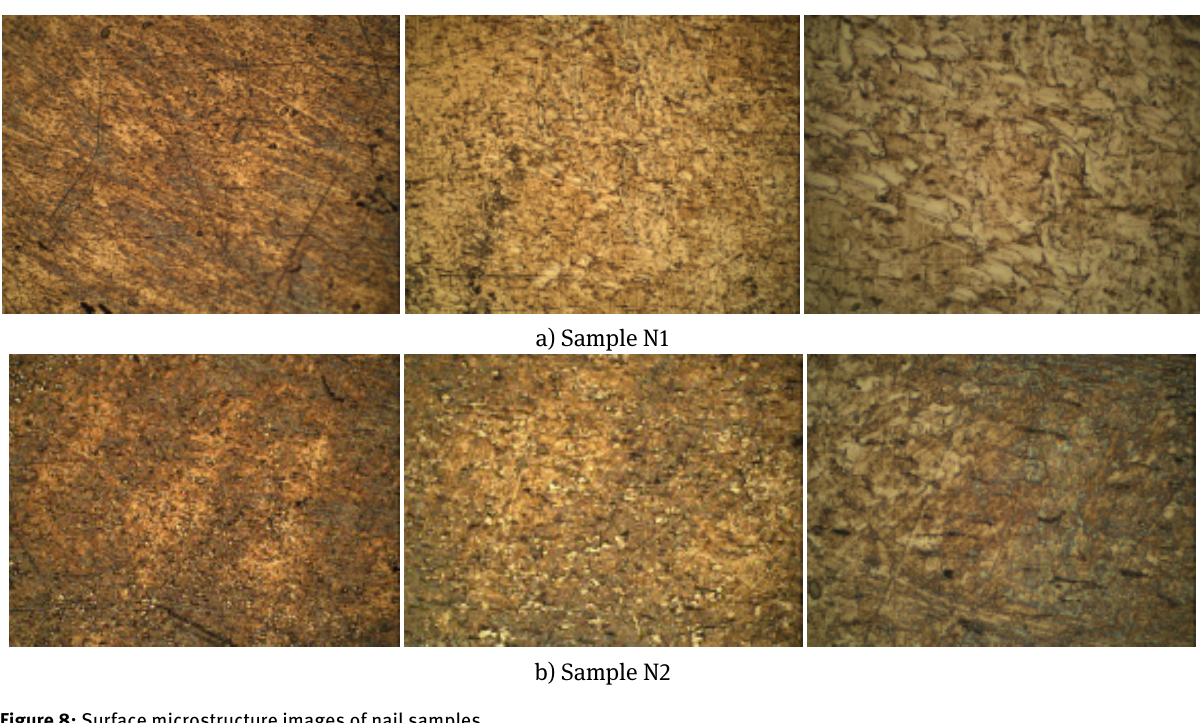
Figure 8: Surface microstructure images of nail samples. Table 2: Elemental chemical analysis (% mass).